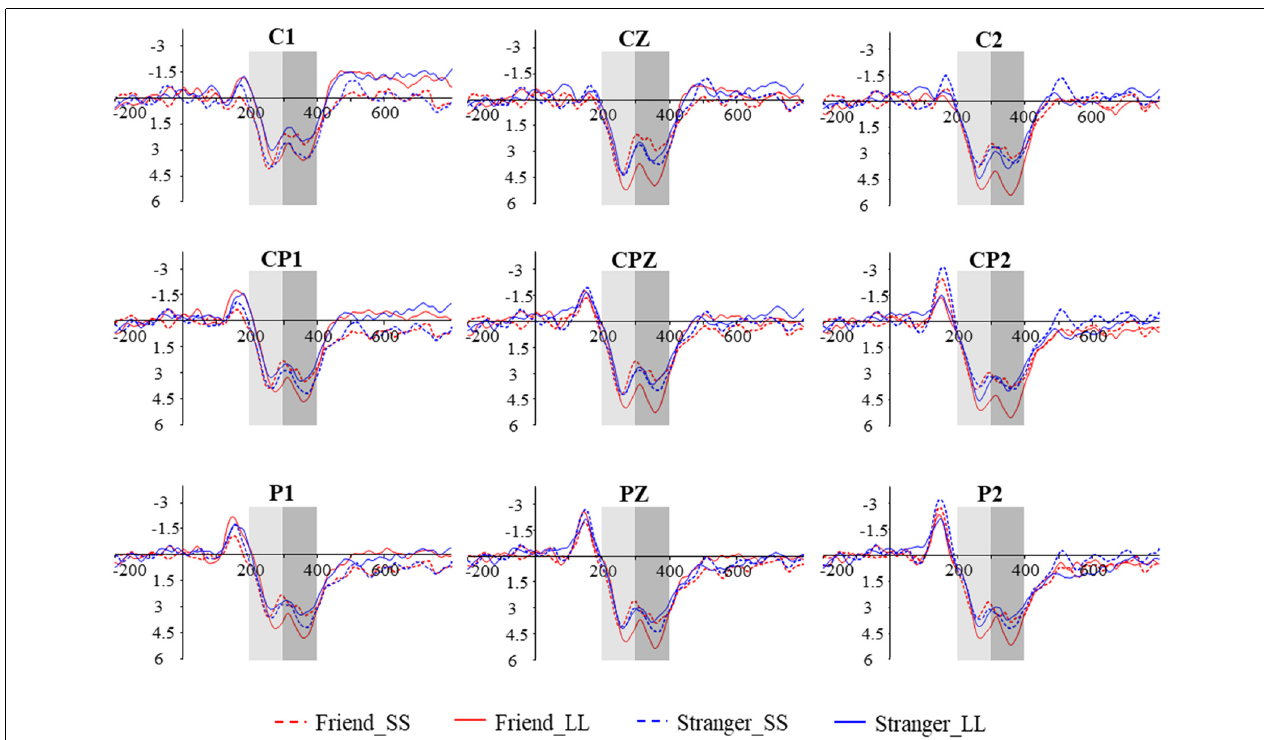
FIGURE 2 | Grand-averaged ERP waveforms from nine electrodes in four conditions. The time window of P3a and P3b are 200–300 ms and 300–400 ms, respectively.